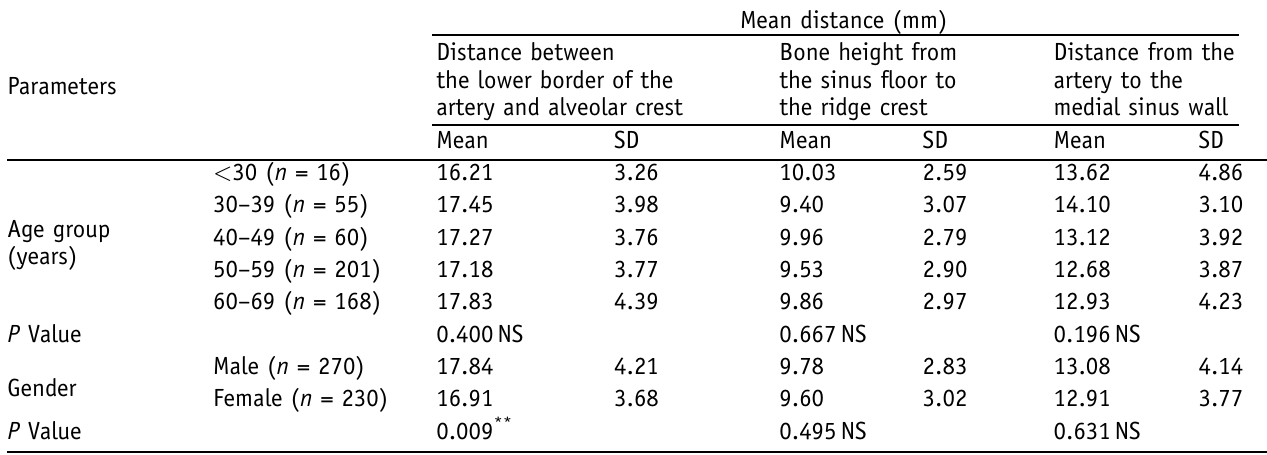
Table II. Comparison of mean radiographic measurements acoording to age and gender (One-way Anova test).